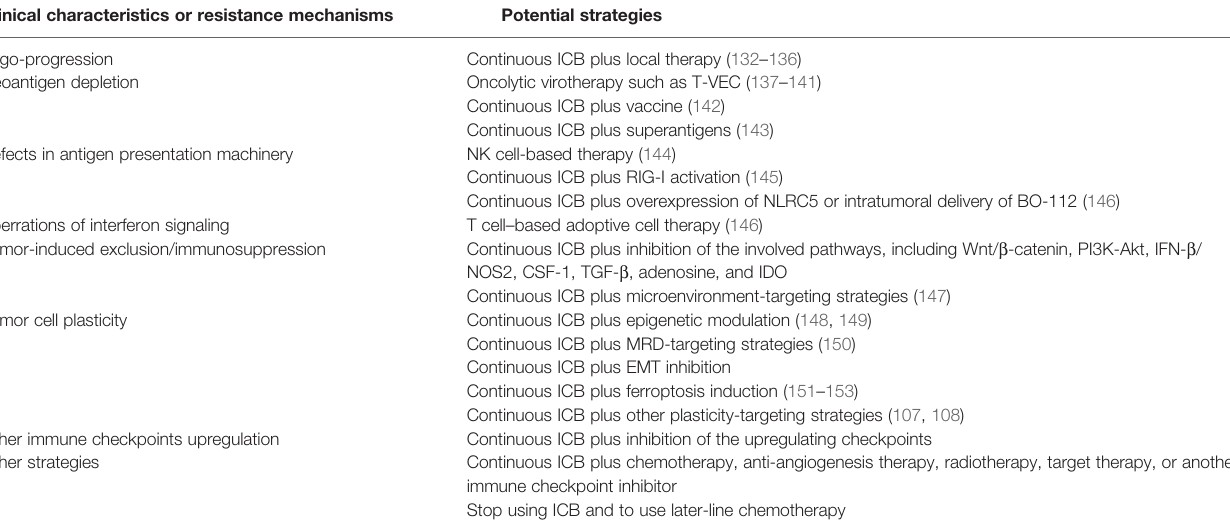
TABLE 3 | The potential strategies to overcome acquired